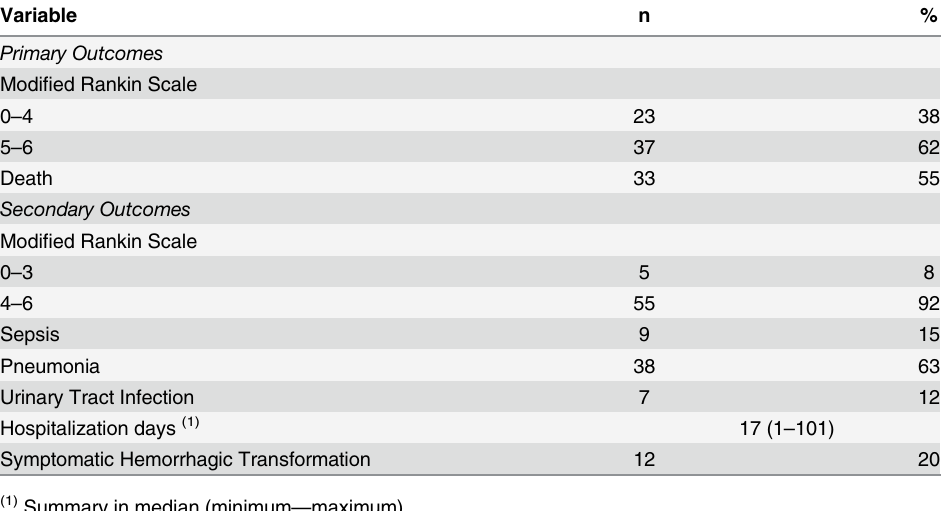
Table 3. Primary and secondary outcomes of the sample.